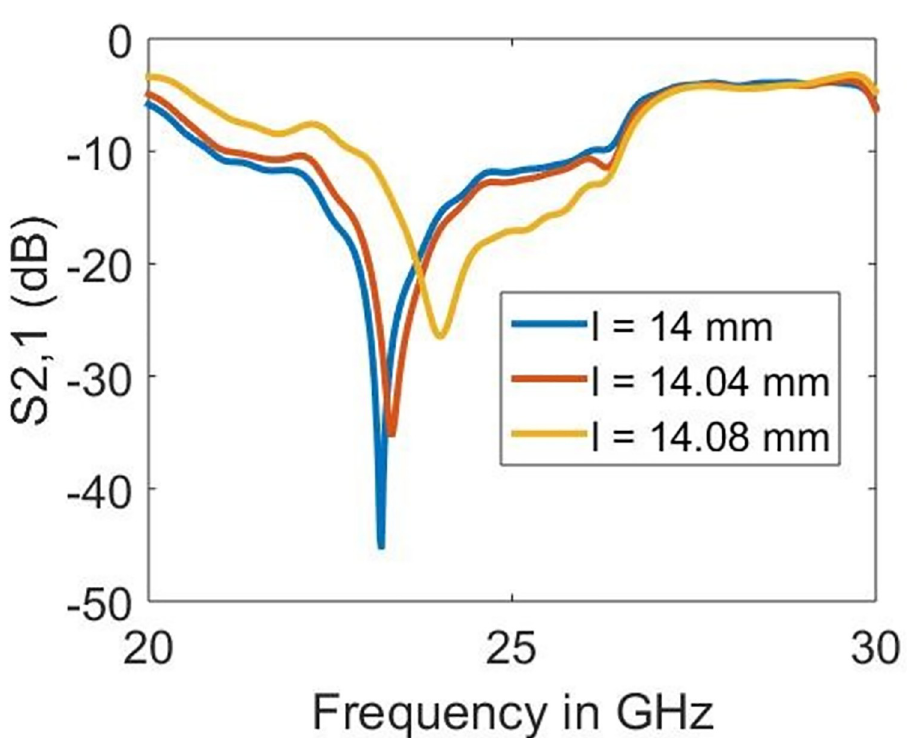
Fig 8. Effect of length on the resonance